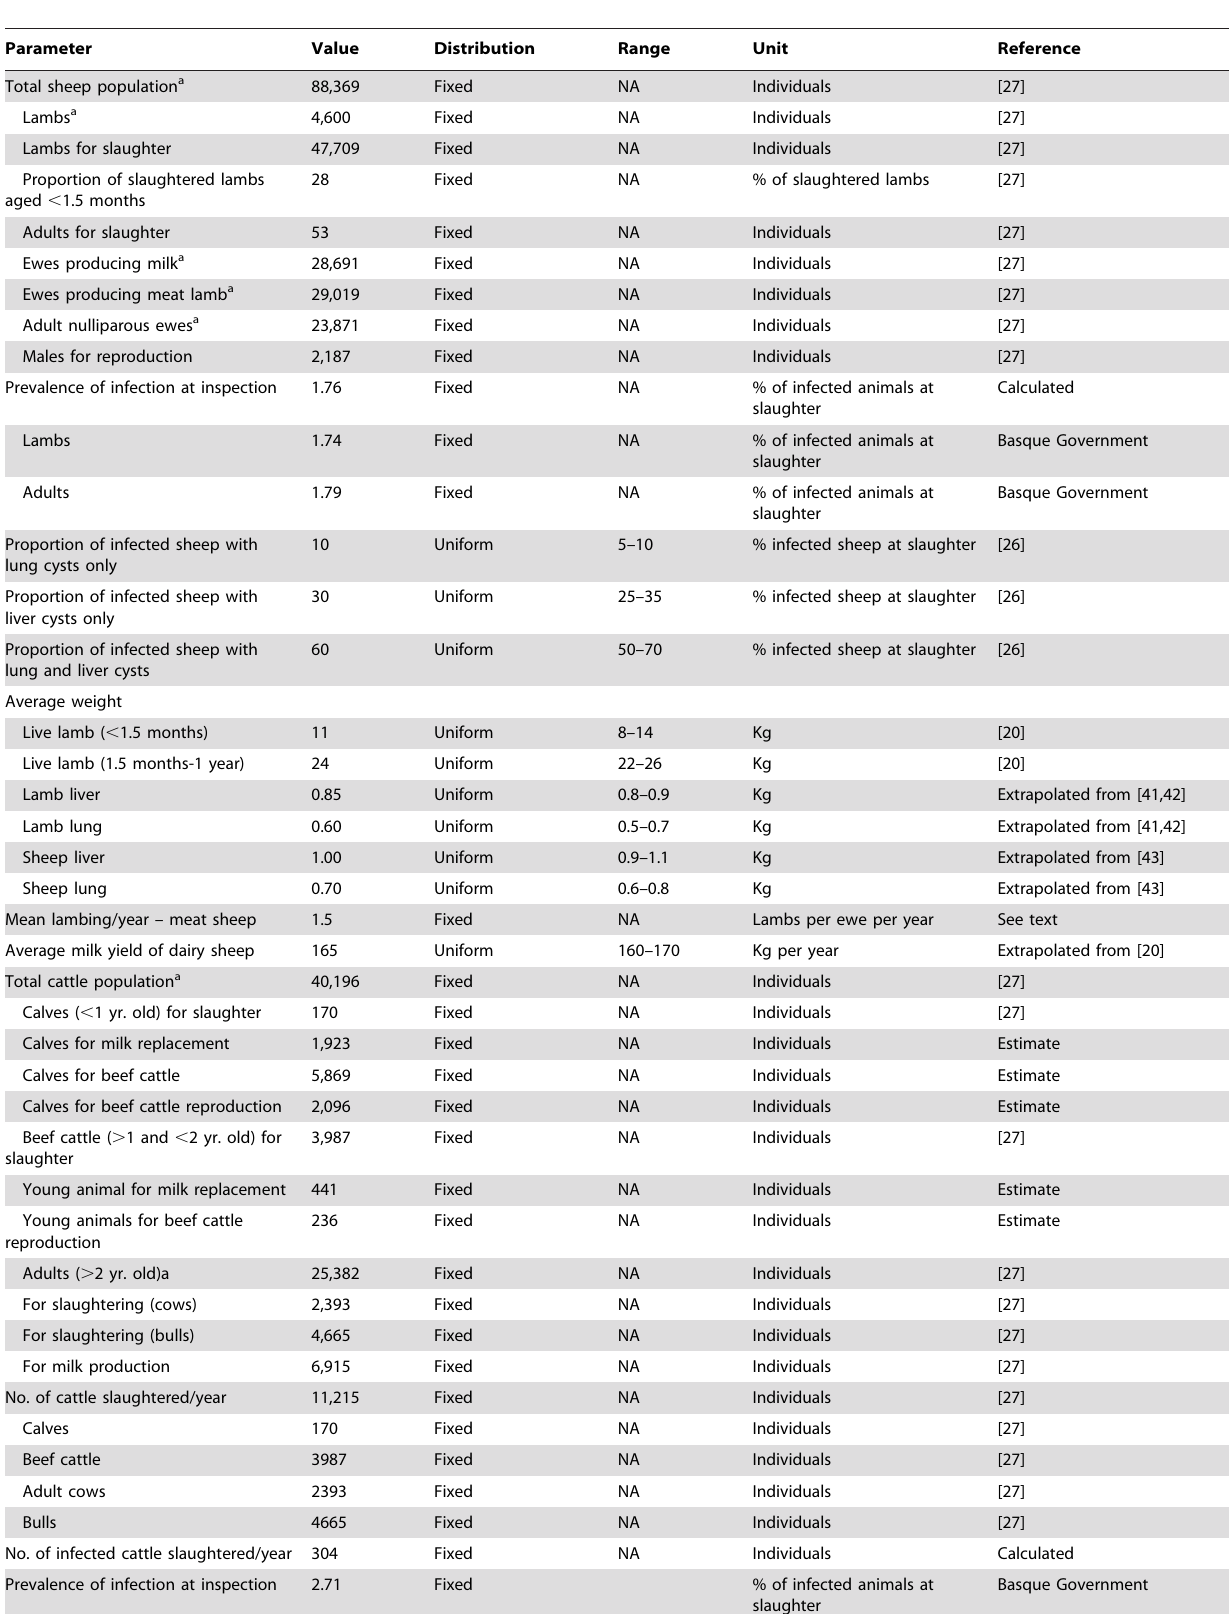
Table 4. Epidemiological parameters used to estimate the economic losses associated with CE in livestock, A´lava,